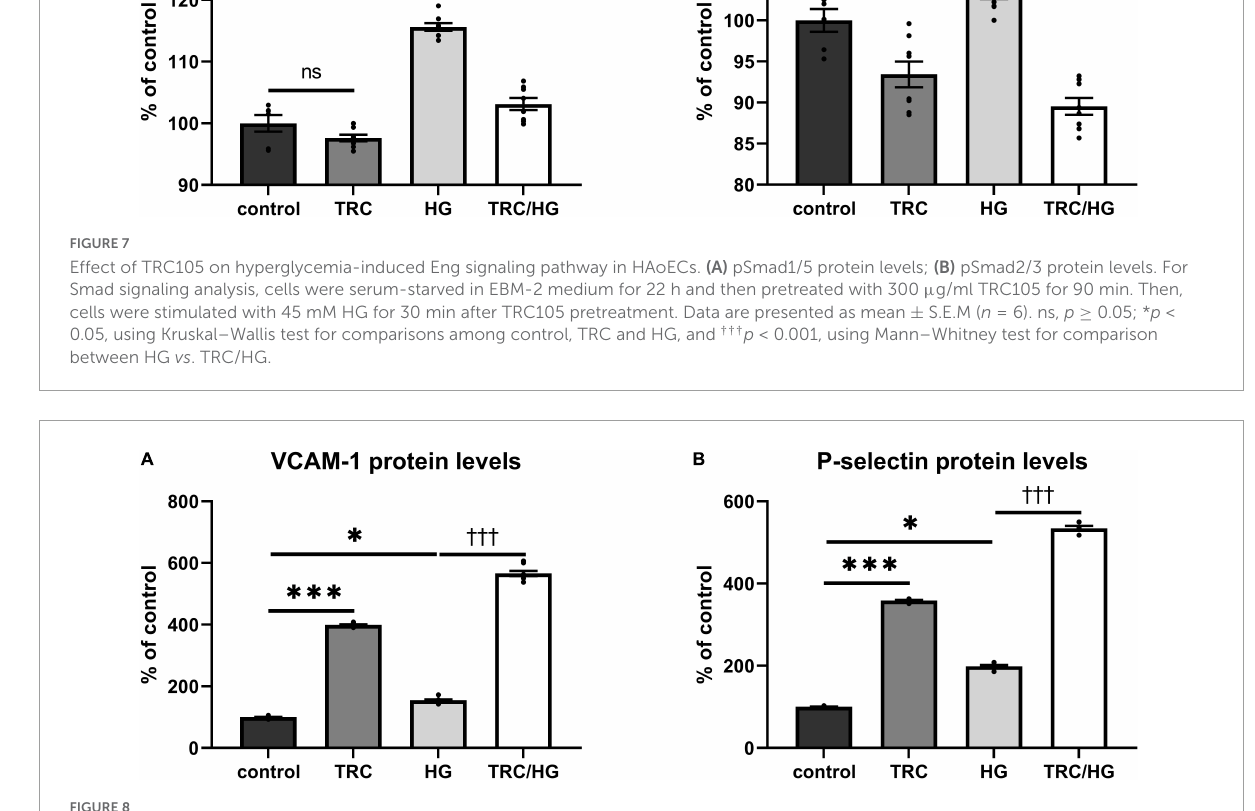
FIGURE8 Effect of TRC105 on hyperglycemia-induced protein levels of cell adhesion molecules in HAoECs. (A) VCAM-1 protein levels. (B) P-selectin protein levels. For the detailed experimental design, please see Figure 1 . The data are presented as mean ± S.E.M ( n = 6). ns, p ≥ 0.05; * p < 0.05; *** p < 0.001, using Kruskal–Wallis test for comparisons among control, TRC and HG, and ††† p < 0.001, using Mann–Whitney test for comparison between HG vs .